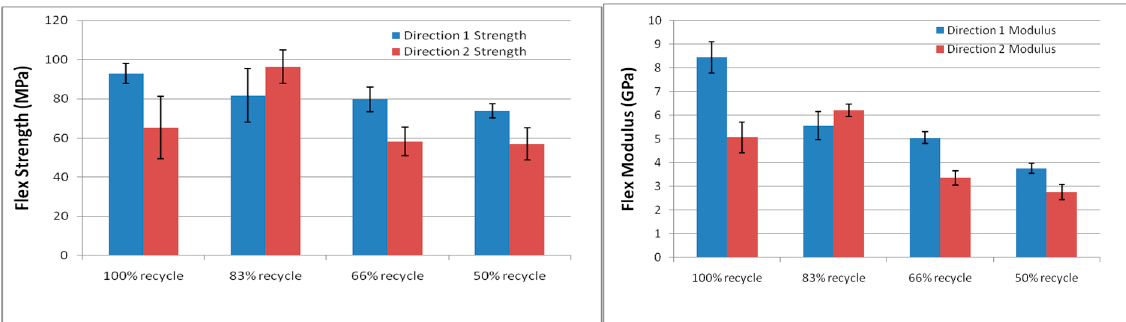
Table 4. Summary of flexure tests for various recycled fiber contents for ‘Longitudinal’ and ‘Trans- verse’, respectively.